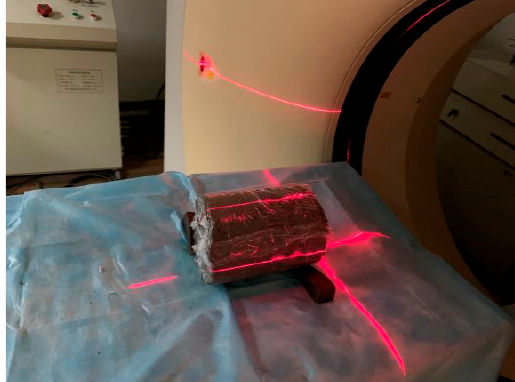
0℃ Figure 6. Temperature distribution during the model test. In order to more intuitively show the distribution of the temperature field, the cloudy map of the freezing process is shown in Figure 7 and that of the melting process is shown in Figure 8.